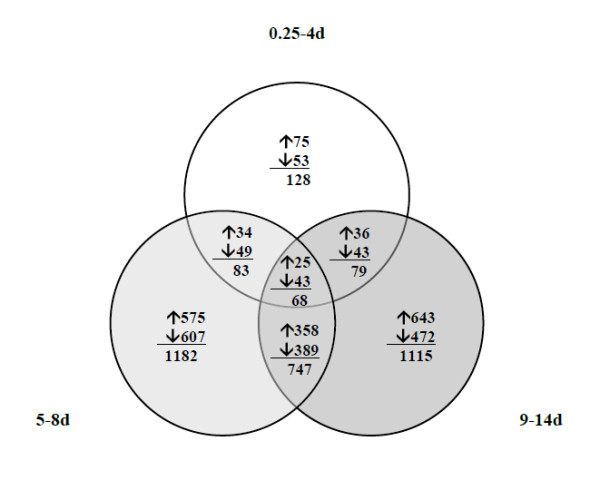
Number of genes differentially expressed at short (0.25-4d), intermediate (5-8d) and long (9-14d) durations. Number of genes regulated at more than one time point are found in overlapping regions. Upward arrows indicate up-regulation and downward arrows indicate down-regulation.